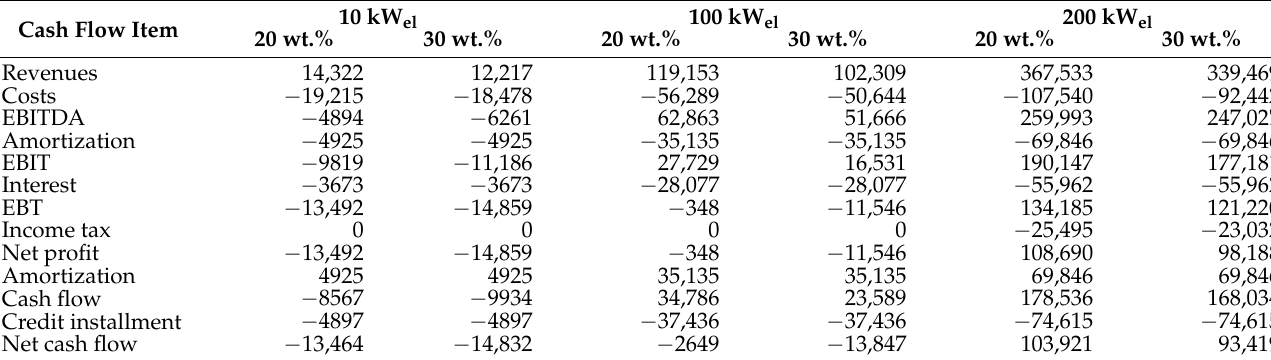
Table 8. Cash flow items of individual variants in the first year of operation in